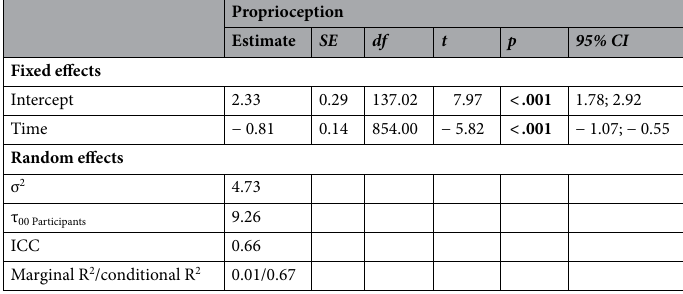
Table 4. Final linear mixed model for the dependent variable proprioception.